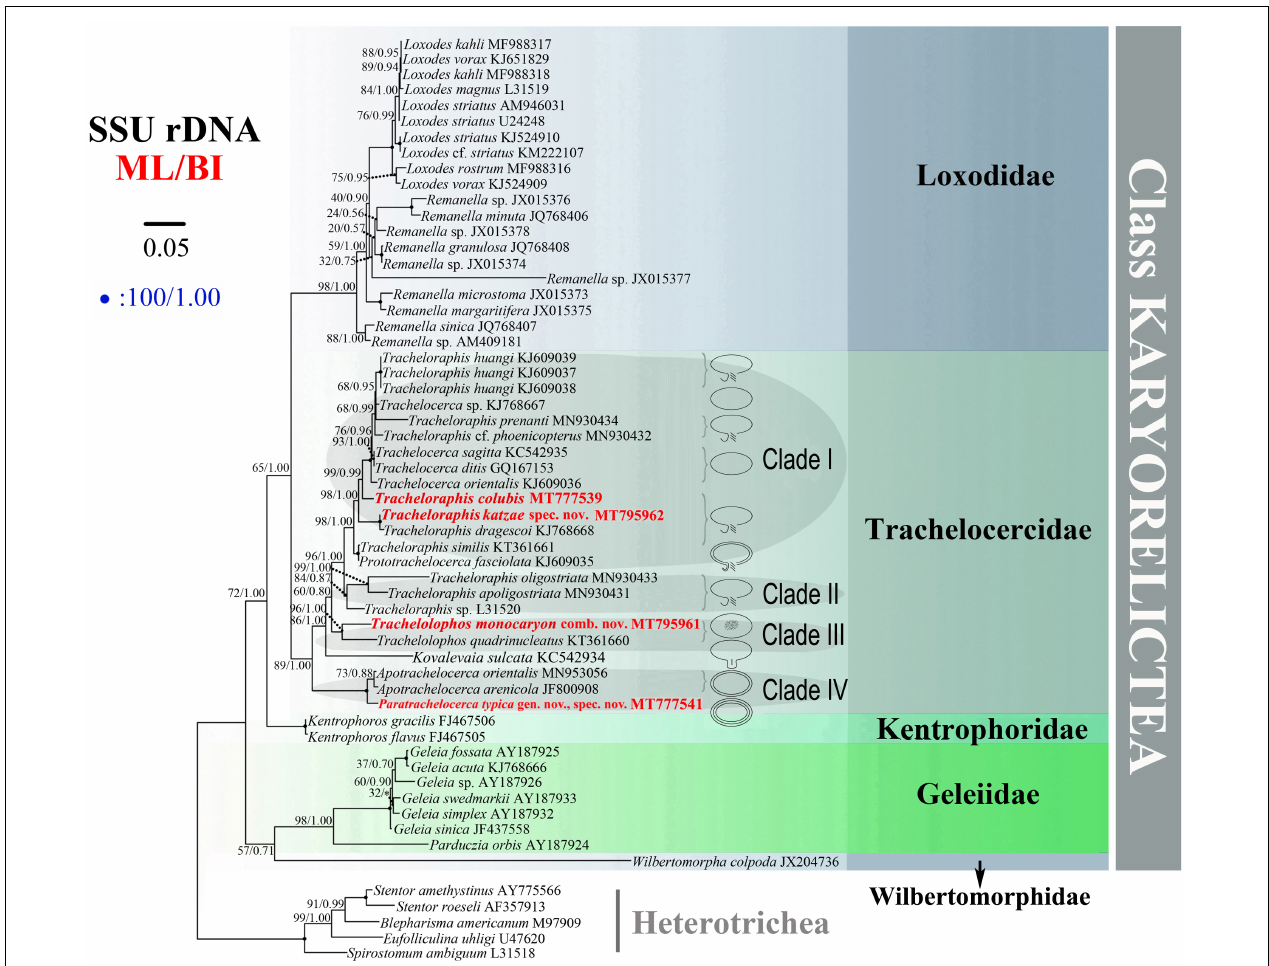
FIGURE 11 | Maximum likelihood (ML) tree inferred from the small subunit rDNA sequences showing the positions of the four newly sequenced Trachelocercidae isolates (in red bold). Nodal support for branches in the ML and BI trees marked in order. Black circles indicate full support in both analyses. Clades with a different topology between the two analyses are shown by an asterisk. Heterotrichous species are the outgroup. The line diagrams show the oral structure of different genera in Trachelocercidae. All branches are drawn to scale. The scale bar corresponds to five substitutions per 100 nucleotides positions.